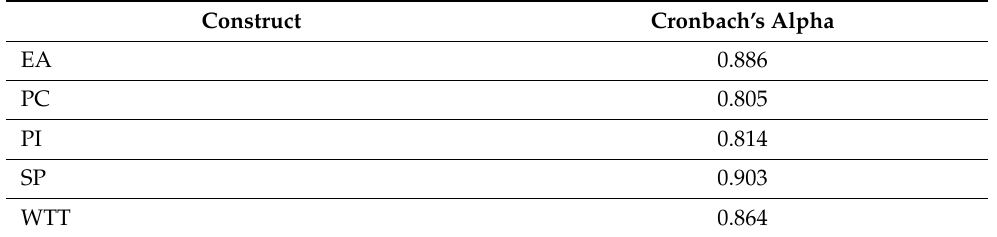
Table 2. Cronbach’s Alpha values for the pilot study (Cronbach’s Alpha ≥ 0.70).